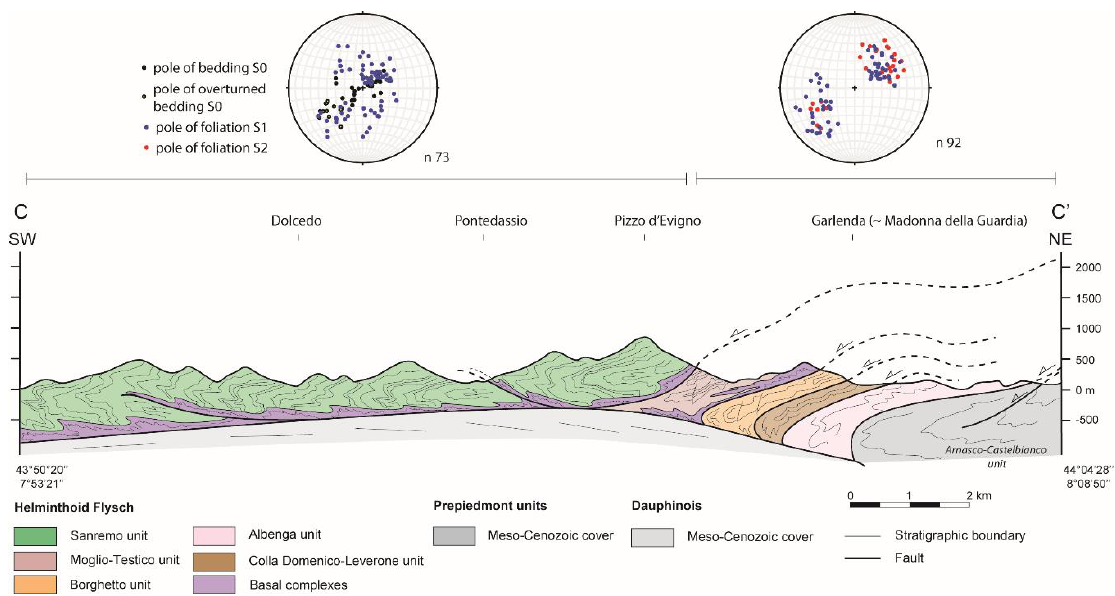
Figure 8. Cross-section C-C’. See Figure 3 for the map location. Lower hemisphere, equal area stereonets of representative foliation data. The section has been divided in two sectors internally homogeneous.